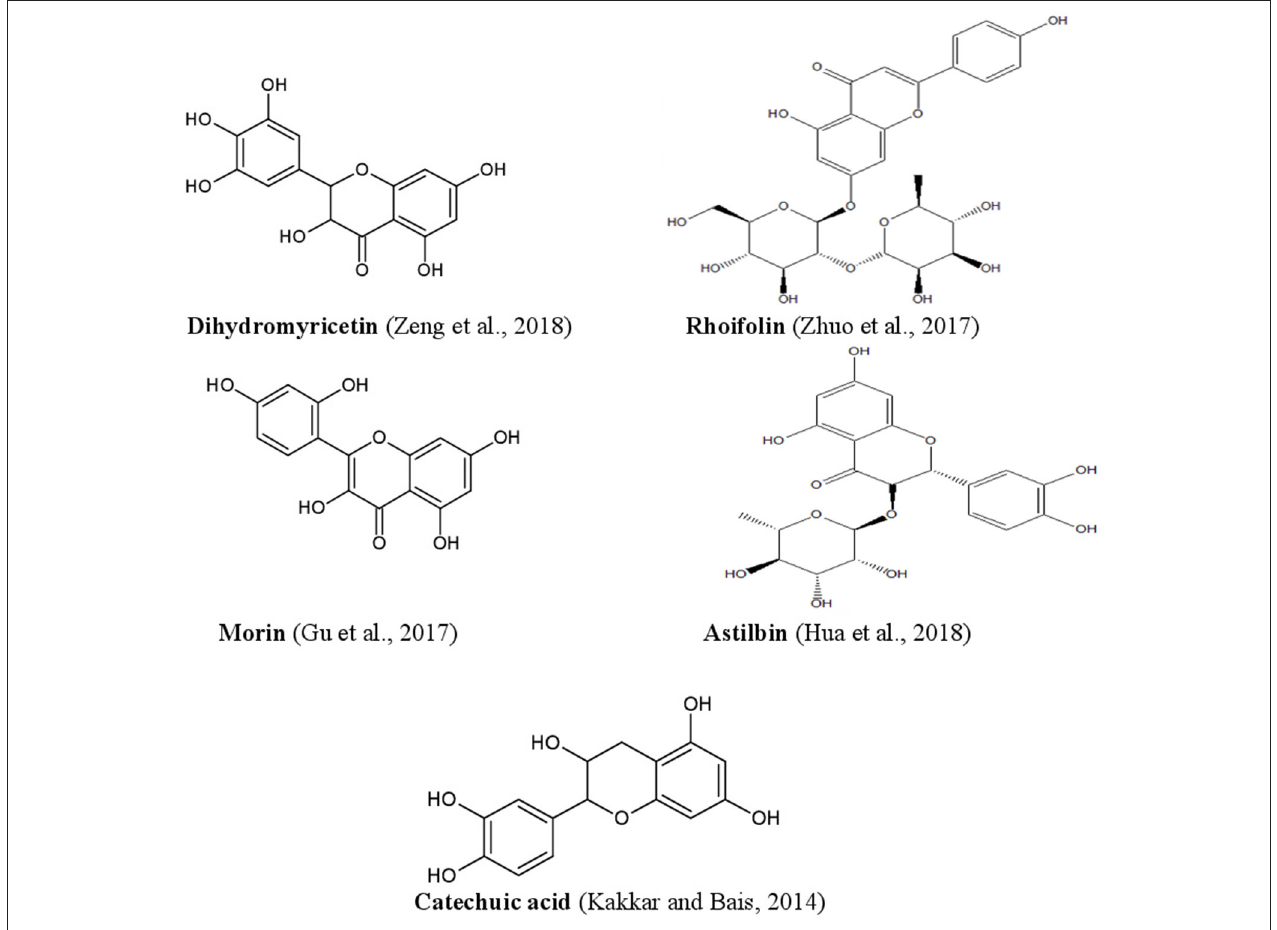
FIGURE 6 | Structures of some bioactive phenolics acting as hepatoprotective